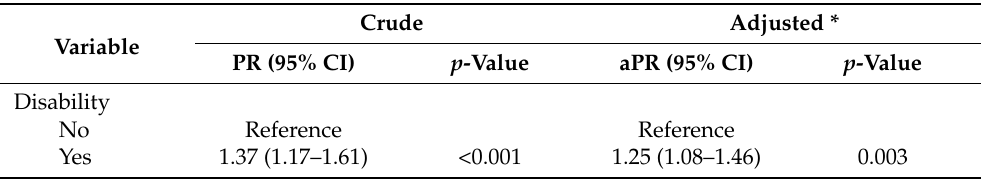
Table 4. Association between disability and unmet need for access to food in the household among Venezuelan migrants and refugees, ENPOVE